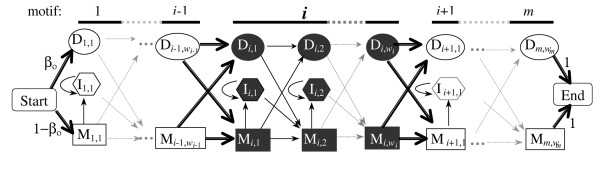
General architecture for our multiple motif HMM. States and transition probabilities between states are defined in Methods. Bold transition arrows emit residue strings.